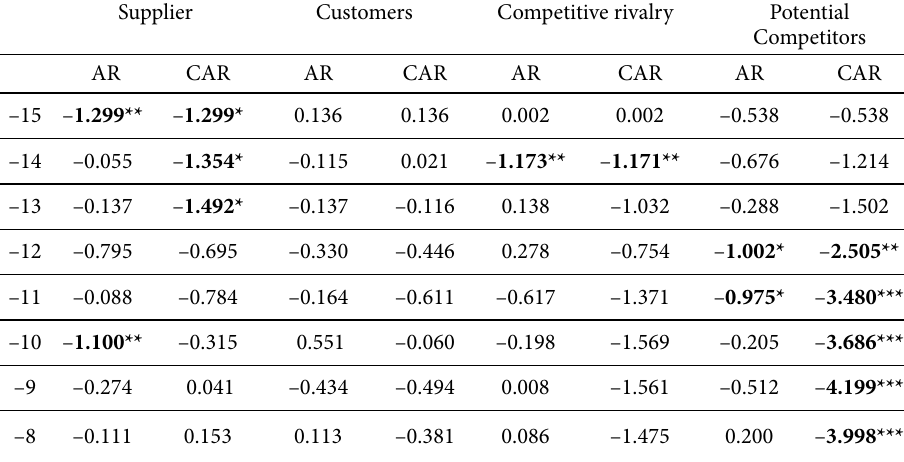
Table 1. Patent infringement from different